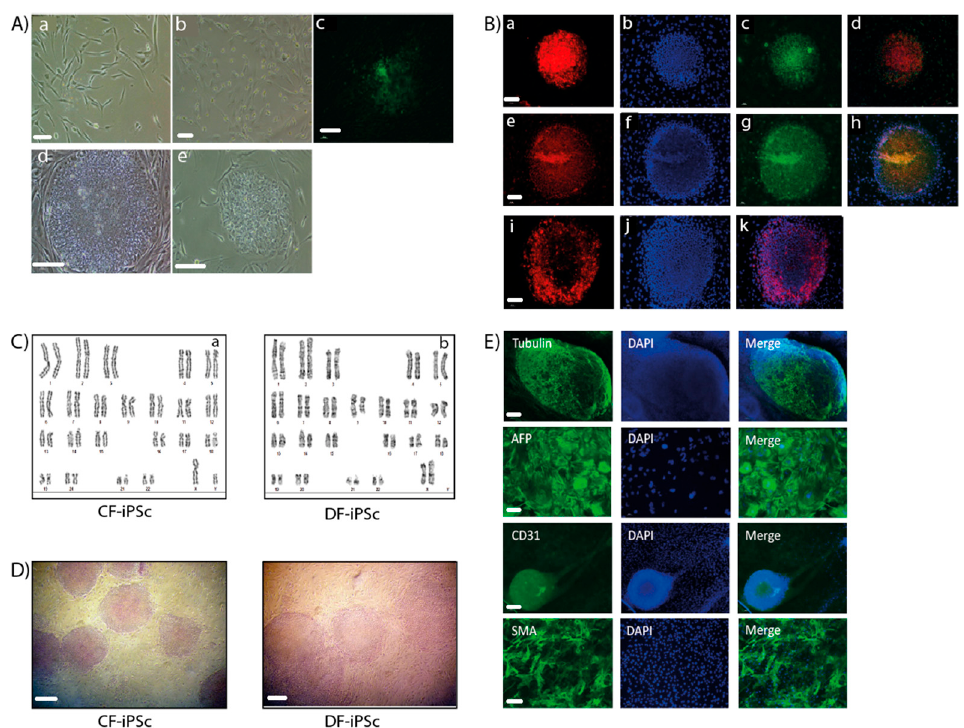
Figure 1. Generation of induced pluripotent stem cells (iPSCs). ( A , a ) A representative image of skin fibroblasts isolated from skin biopsies. ( b ) A representative image of cardiac apex fibroblasts isolated from cardiac apex biopsies. Scale bars ( a , b ), 100 µm. ( c ) Immunostaining of live cells using TRA-1-60 marker, derived from reprogramming the skin fibroblasts. ( d ) Representative image of a skin fibroblast-derived iPSC colony. ( e ) Representative image of a cardiac apex fibroblast-derived iPSC colony. Scale bars ( C , E ), 200 µm. ( B ) Immunofluorescence detection of cellular marker expression in iPSC. iPSC demonstrated staining of TRA 1–60 ( a ), Nanog ( c ), Sox2 ( e ), Oct4 ( g ), and TRA-1-81 ( i ). DAPI (4 ′ ,6-diamidino-2-phenylindole ) staining of the nuclei ( b ), ( f ), and ( j ). Merged staining images ( d ), ( h ), and ( k ). Scale bars ( a – k ), 200 µm. ( C ) Karyotype of CF-iPSC ( a ) and DF-iPSC ( b ). ( D ) Alkaline phosphatase staining of cardiac fibroblasts (CF-iPSC)- and skin (DF-iPSC)-derived iPSCs. Scale bars, 100 µm. ( E ) iPSC lines can spontaneously differentiate into the three germ layers. Microdissected contracting areas were stained for typical myofilament proteins. Immunostaining of iPS-derived embryoid bodies (EBs) revealed the expression of ectodermal ( β ll-tubulin; scale bars, 200 µm), endodermal (AFP (alpha fetoprotein); scale bars, 10 µm), and mesodermal (CD31, SMA (smooth muscle actin ) ; scale bars, 20 µm) markers. Nuclei were stained with DAPI.